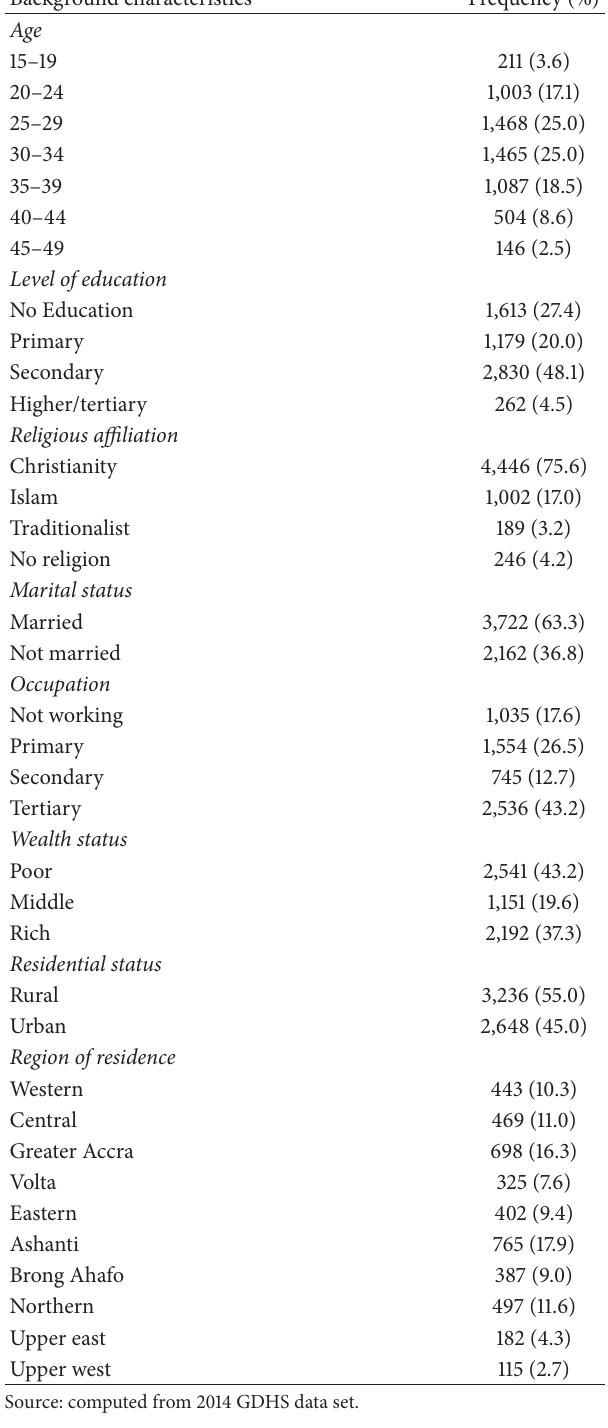
Table 1: Background characteristics, Ghana DHS 2014 ( 𝑁 =